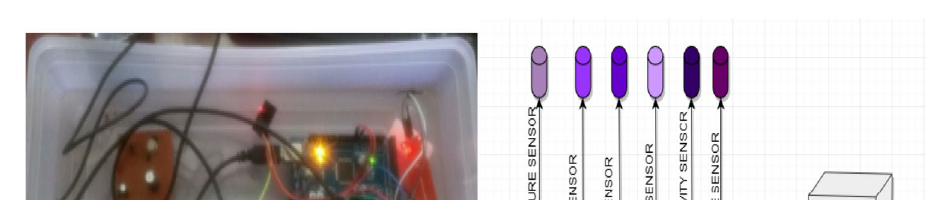
Fig. 2 The circuit and the block diagram of IoT